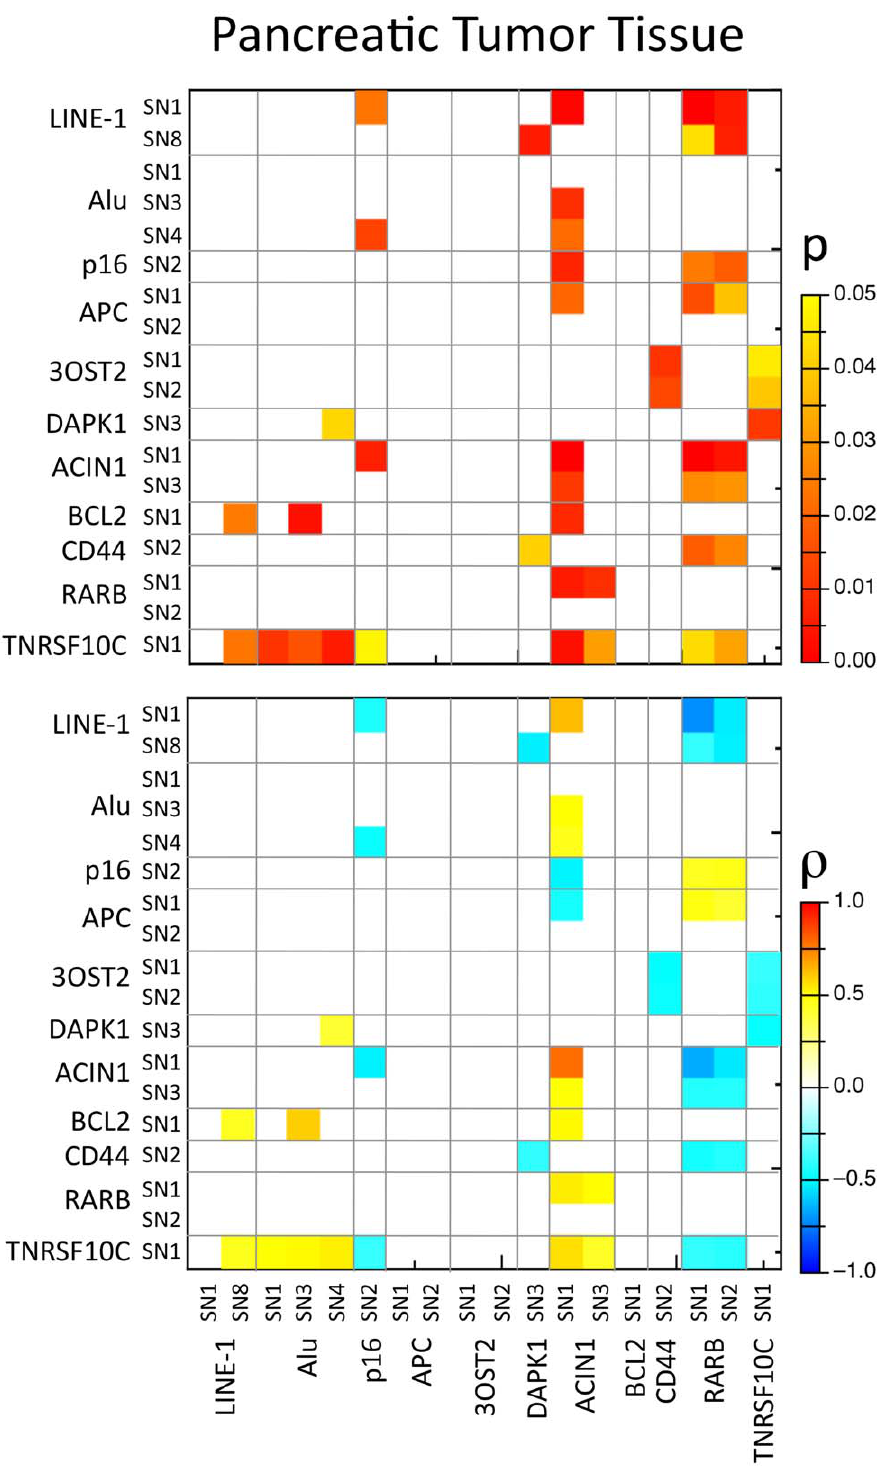
Figure 4. Heatmap showing p values and significant Spearman correlation coefficient ( r ) between methylation levels of different CpGs in paired peripheral blood and ductal adenocarcinoma tissues (p values of . 0.05 are in white, the shown r -values are corresponding to p values , 0.05).